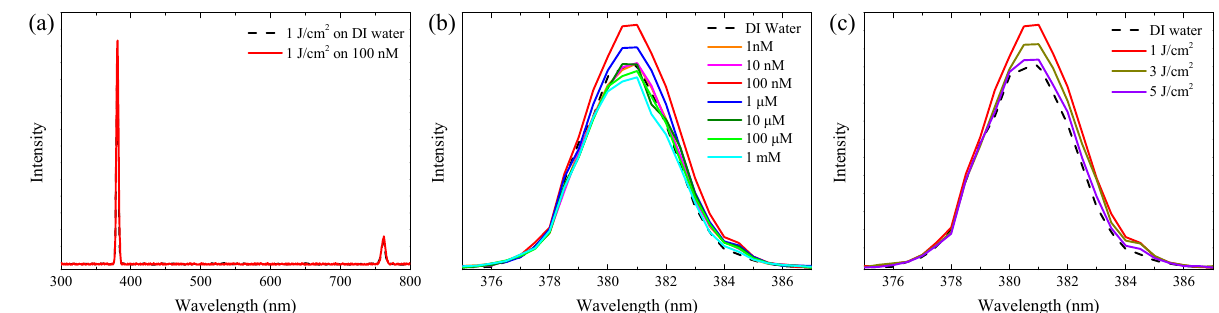
Figure 6. PL spectra of the bare and Ag-decorated ZnO NWs: ( a ) full spectra and peak at 381 nm at different ( b ) AgNO 3 concentrations and ( c ) IPL irradiation energy.